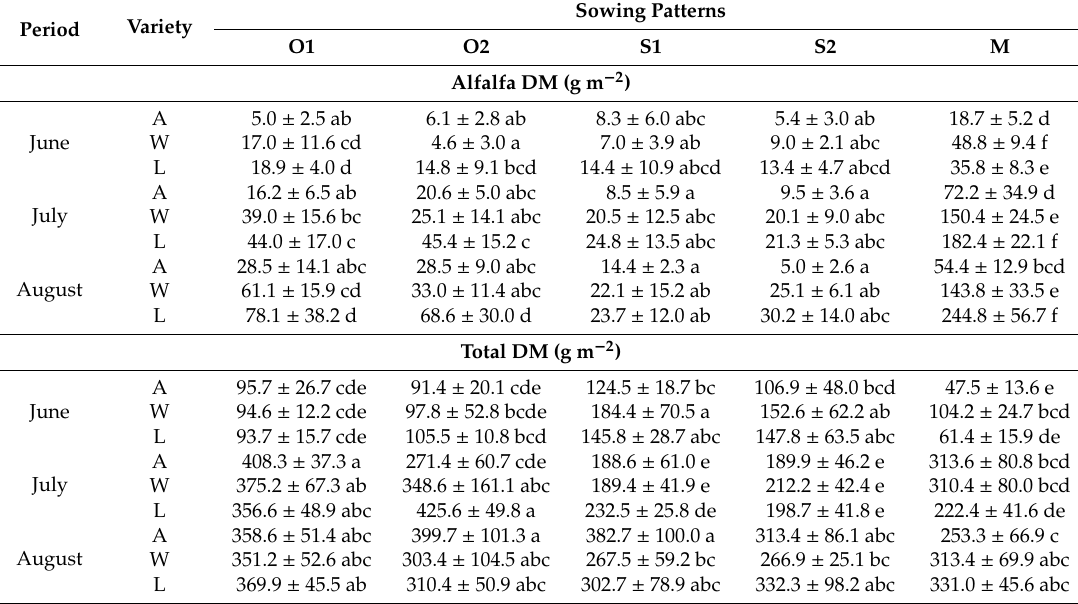
Table 2. Alfalfa dry mass (DM) and the total DM of all treatments during the growing season. Period